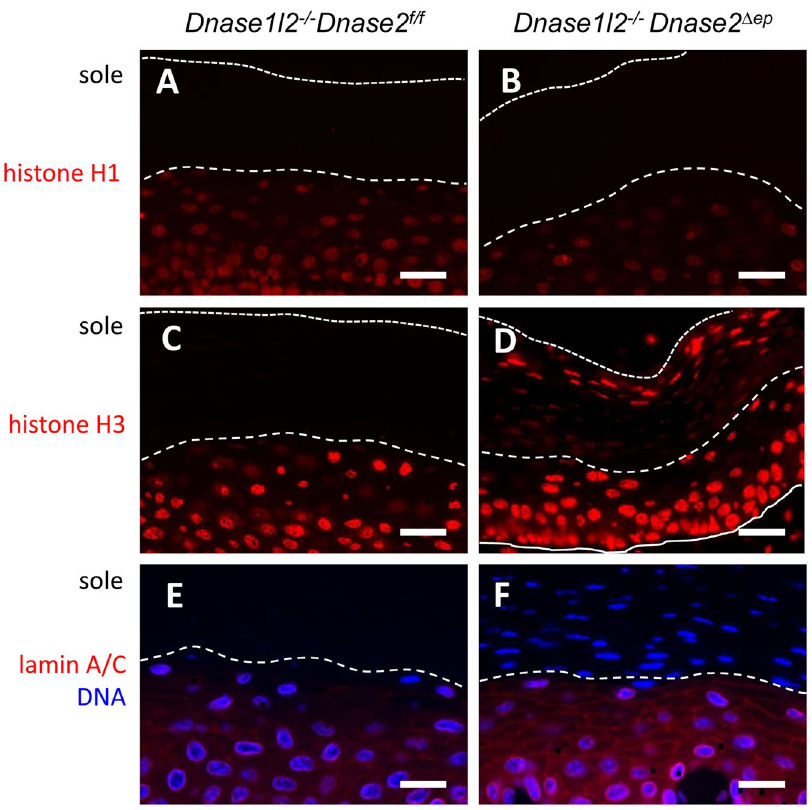
Figure 3. Immunofluorescence labeling of histones and lamin. Thin section of the skin on the soles of Dnase1l2 − / − ( A , C , E ) and Dnase1l2 − / − Dnase2 Δ ep mice ( B , D , F ) were immunolabeled with antibodies against histone H1 ( A , B ), H3 ( C , D ), and lamin A/C ( E , F ). The sections were counter-stained with the DNA-specific dye Hoechst 33258. Dotted and dashes lines indicate the outer and the inner border of the stratum corneum, respectively. The data are representative of at least 3 mice per genotype. Scale bars, 20 µ